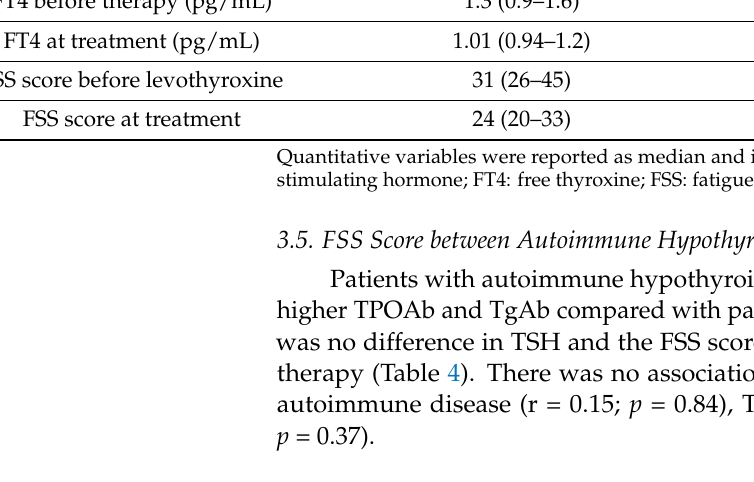
Table 4. Clinical and biochemical differences between autoimmune and unspecified hypothyroidism. Autoimmune (n =